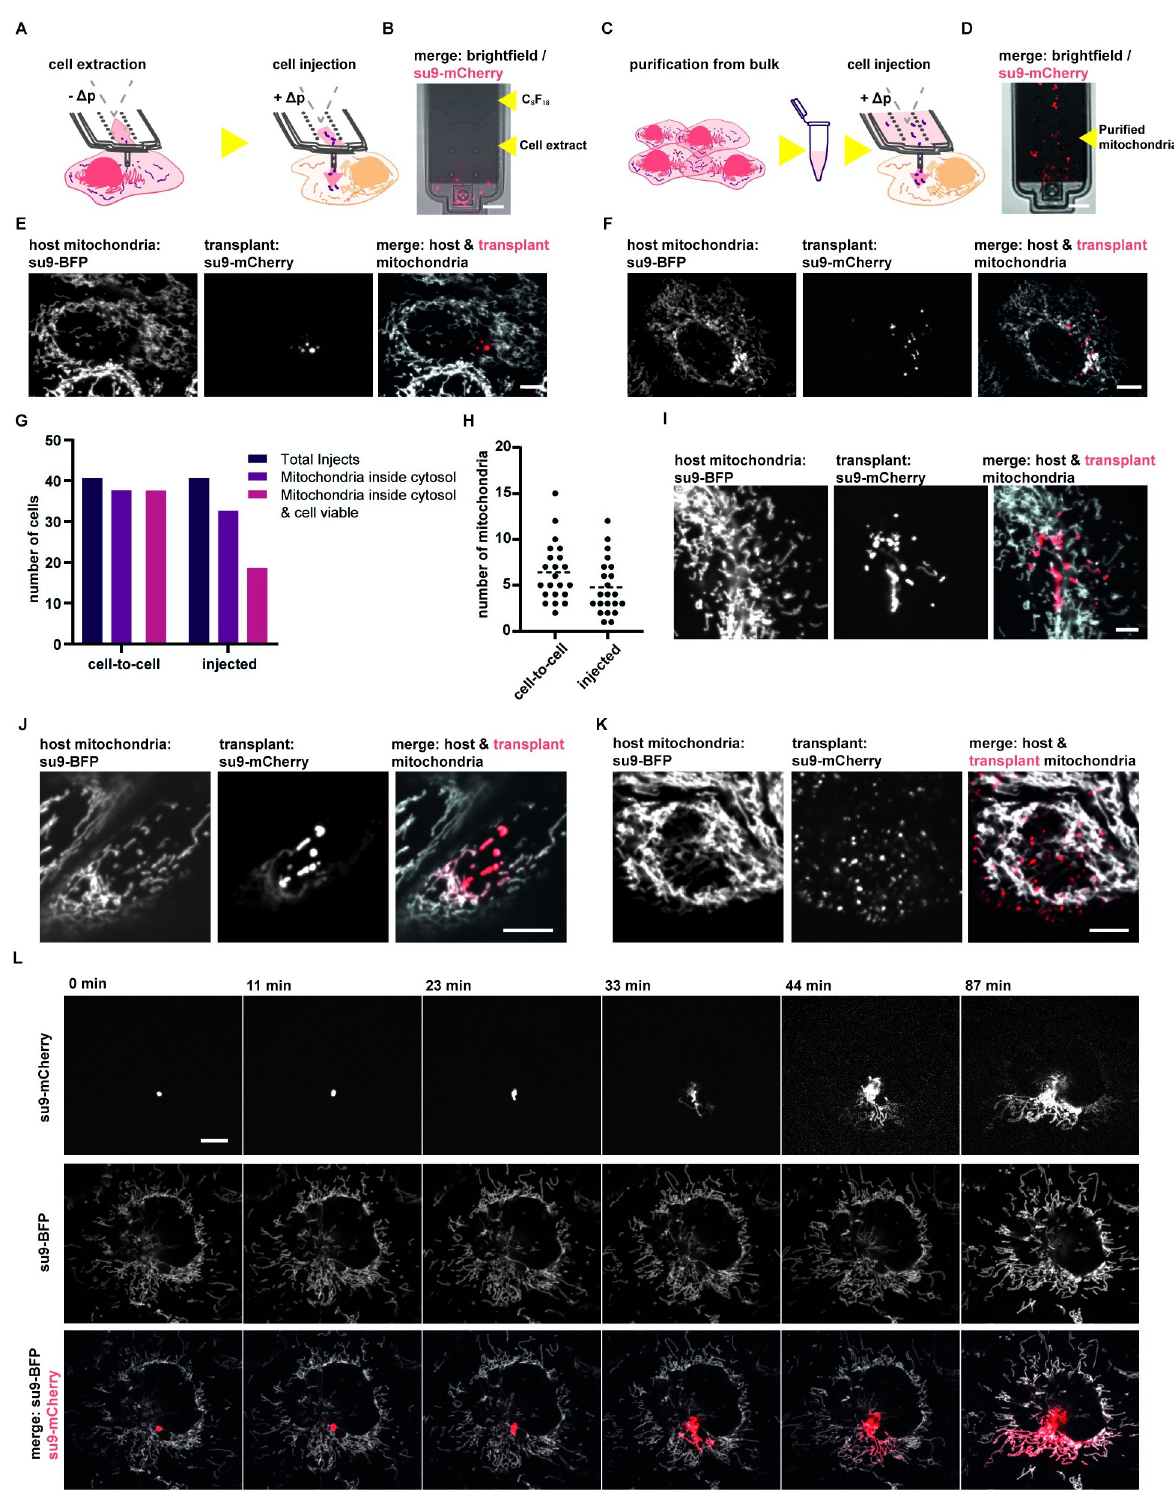
Fig 3. Mitochondrial transplantation. ( A ) Scheme of mitochondrial transplantation using the cell-to-cell transfer approach: Mitochondria are extracted via FluidFM aspiration. Subsequently, the cantilever holding the extract is moved to a recipient cell and the extract is injected. ( B ) Image of a FluidFM cantilever prefilled with perfluorooctane after mitochondrial extraction, mitochondria are labeled via su9-mCherry. Extracted volume approximately 0.8 pL. Scale bar: 10 μ m. ( C ) Scheme of mitochondrial transplantation using mitochondria purified by a standard mitochondrial